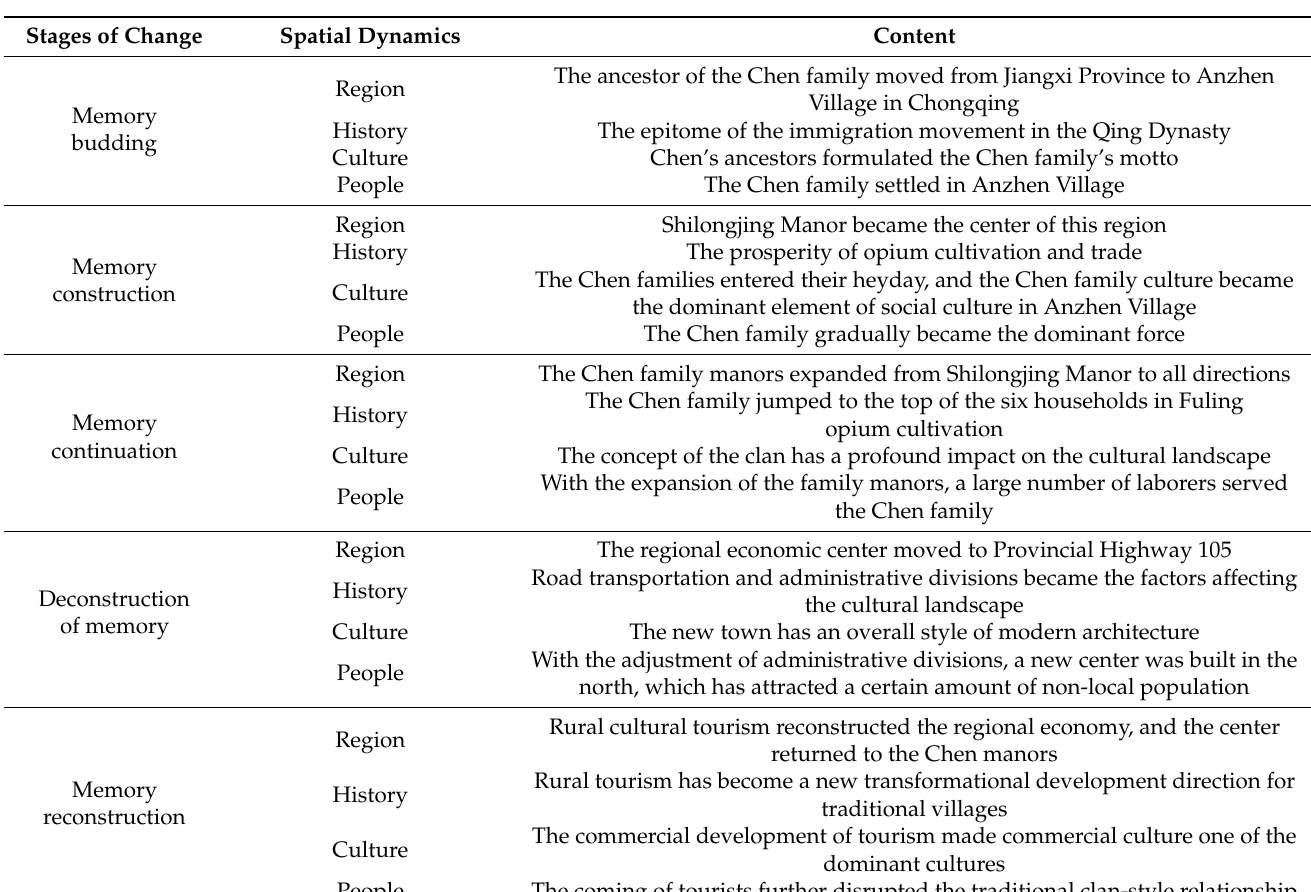
Table 1. The four spatial dynamic analyses of the cultural landscape changes in Anzhen Village (source: Drawn by the